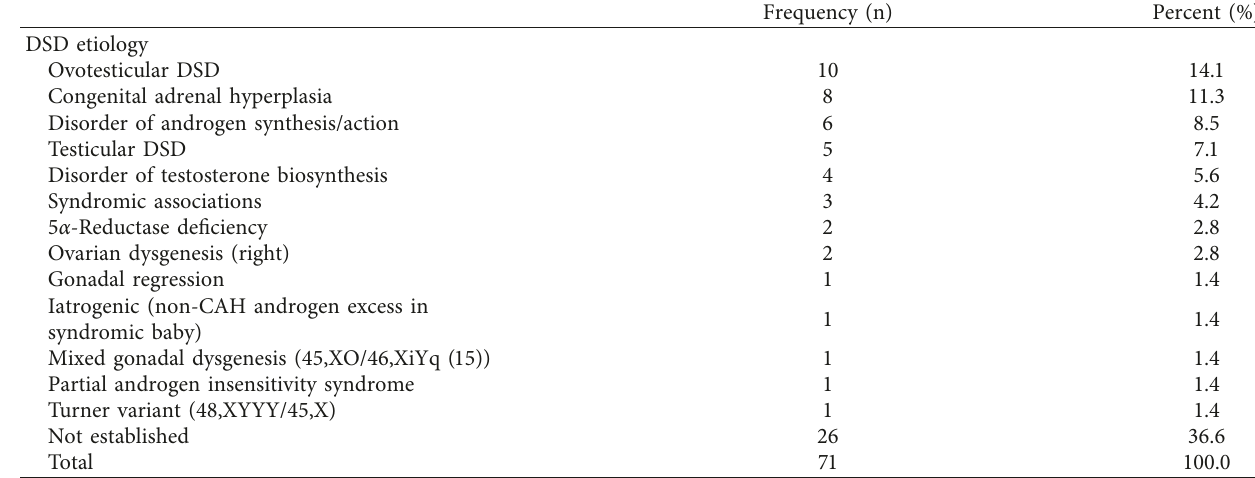
Table 2: Etiological diagnosis ( n �